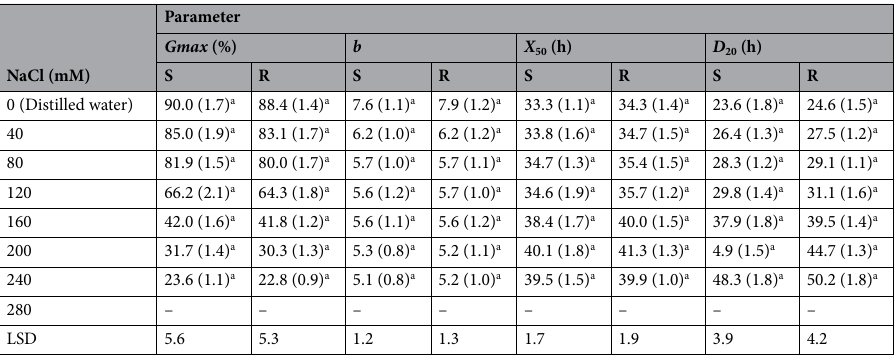
Table 4. Parameter estimates resulted from the fitting of three-parameter sigmoidal function to seed germination data associated with herbicide-resistant (R) and -susceptible (S) winter wild oat biotypes over time under different salinities. The values in parentheses denote standard error. Similar letters denote insignificant difference between the R and S biotype in each parameter. Gmax : maximum germination percentage; b : slope at X 50 ; X 50 : time to 50% of maximum germination at each temperature; D 20 : time to 20%